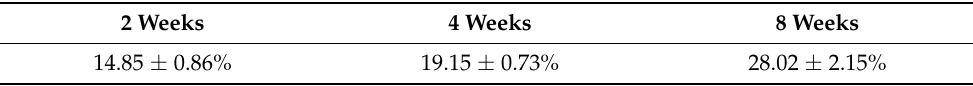
Figure 2. ( A ) Digital camera image and scanning electron microscopy image of lenvatinib unloaded and loaded nanofibers. The fiber diameters were 1555 ± 538 nm and 683 ± 160 nm, respectively. ( B ) Lenvatinib release profile from the nanofiber sheet. Table 1. Cumulative release rate of lenvatinib.